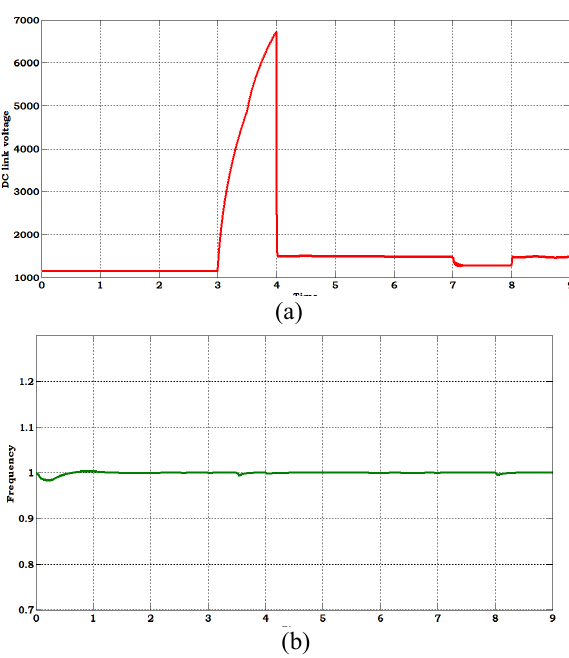
Figure 19. (a). DC link voltage, (b).Frequency Sudden transient occurred at t=3 sec to 4 sec and fault occurred at t=7 sec but still controller is maintaining constant DC link voltage and frequency.